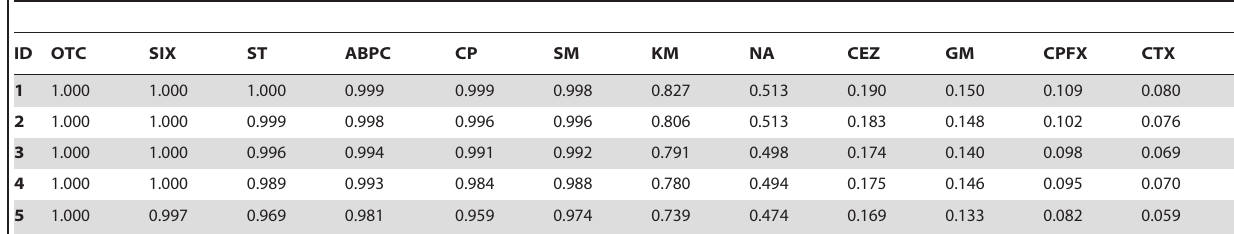
Table 3. Proportion of bootstrap samples detecting one or more E. coli isolates resistant to 12 different antimicrobials, obtained with 6 different sampling strategies and 10,000 bootstrap replications per